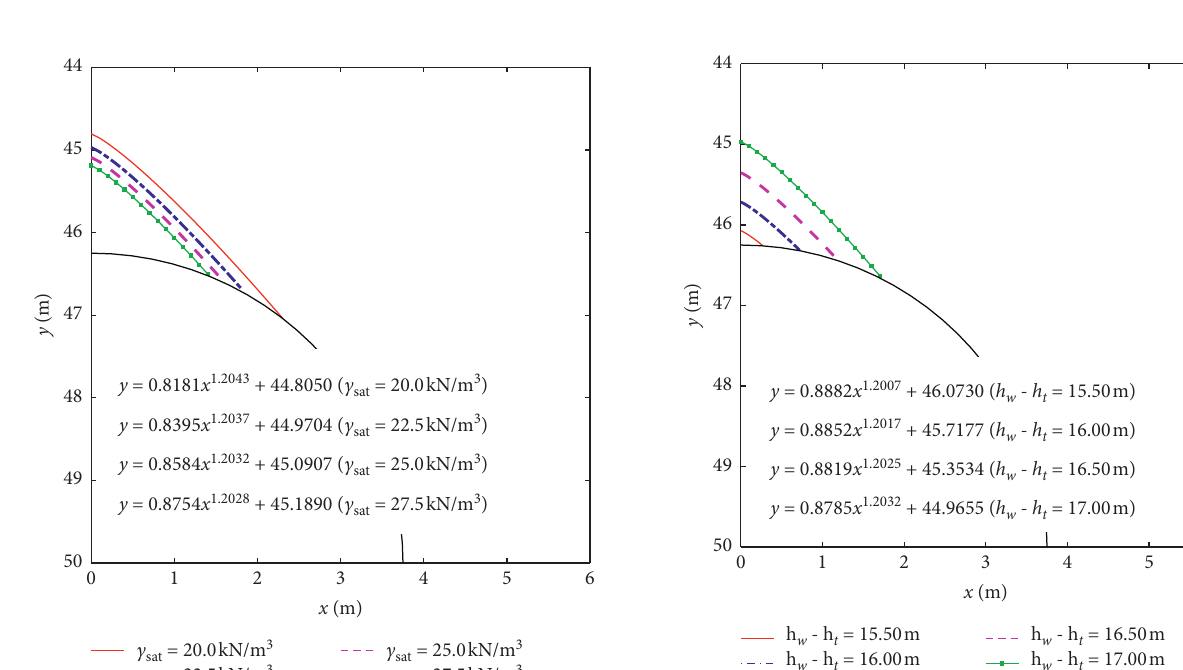
Figure 8: Effect of saturated unit weight of rock masses c collapse mechanisms. The parameters are A � 0.35, B � 5/6,